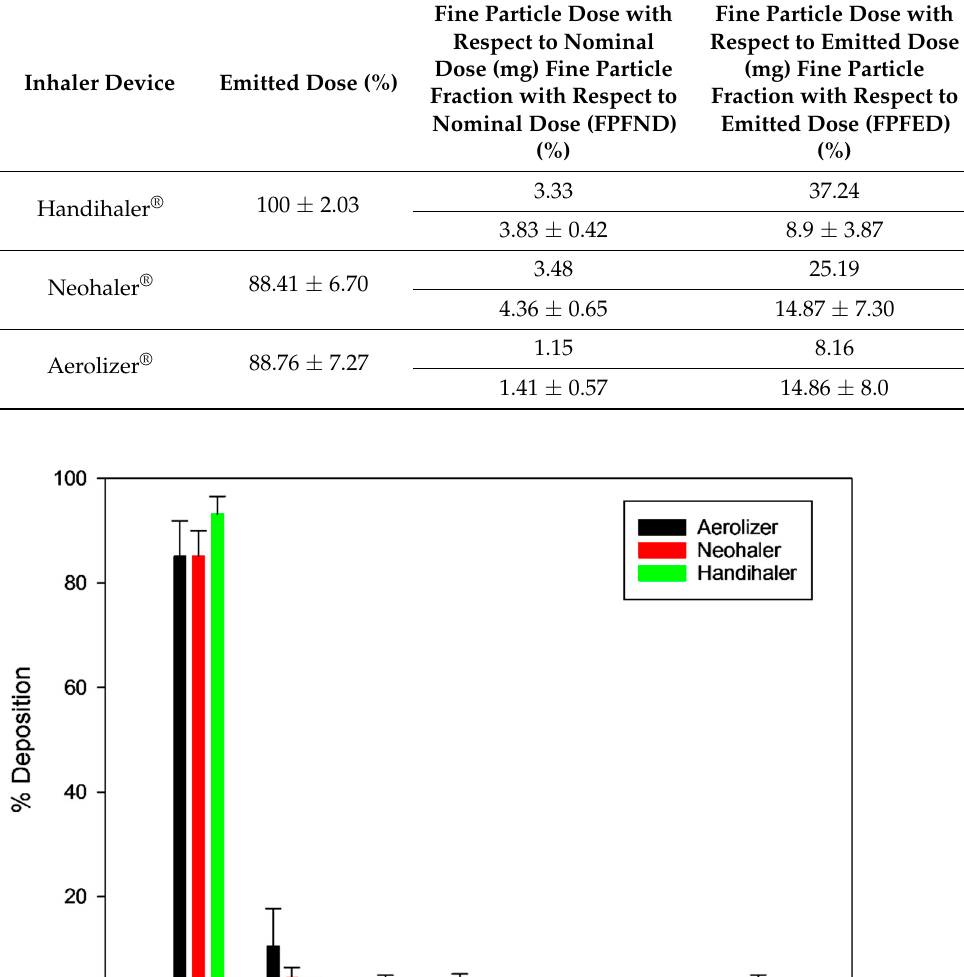
Table 3. In vitro aerosol dispersion performance parameters for spray dried TMP particles using human dry powder inhaler (DPI) devices Aerolizer ® , Neohaler ® and Handihaler ® at 60 L/min. ( n = 3, Mean ± SD). Inhaler Device Emitted Dose (%)